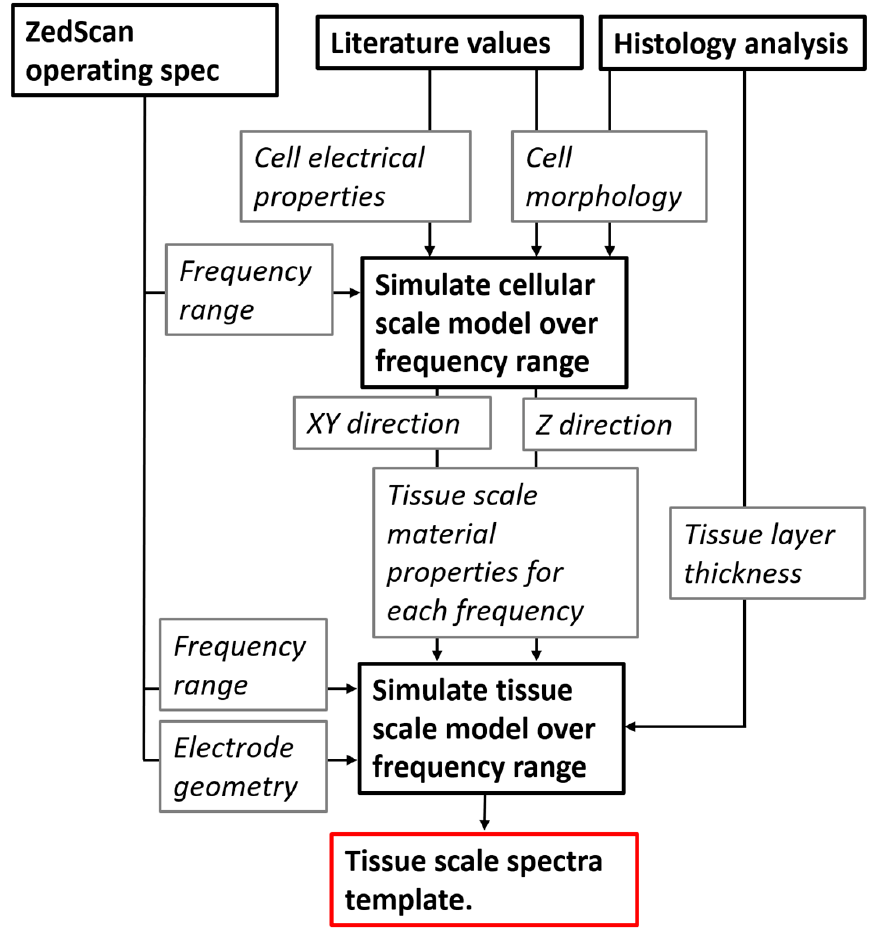
Figure 3. Flow of information between the cellular and tissue scale models including inputs/constraints (current frequency and electrode geometry) associated with the ZedScan system. Both cellular and tissue scale simulations were implemented using a commercial finite element modelling tool ANSYS APDL [22]. Specific modules used are listed in the Supplementary Materials (Section S2) with appropriate mesh size convergence and size effect studies for both scales considered (Section